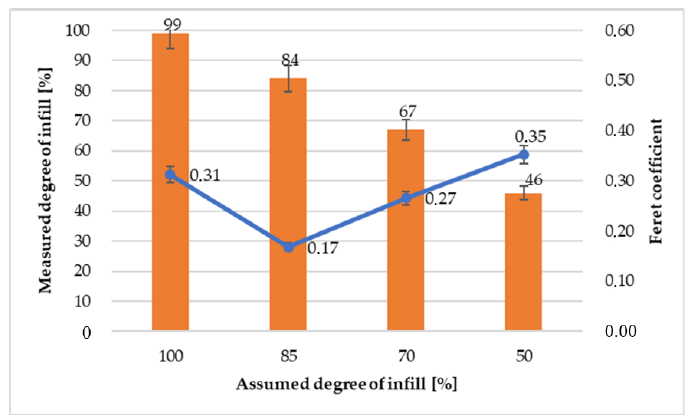
Figure 12. Comparison of the real and assumed amount of infill and Feret coefficient.